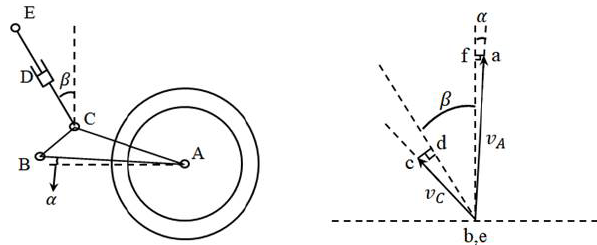
Figure 16. Bounce stroke of the wheel and the spring compression of rear